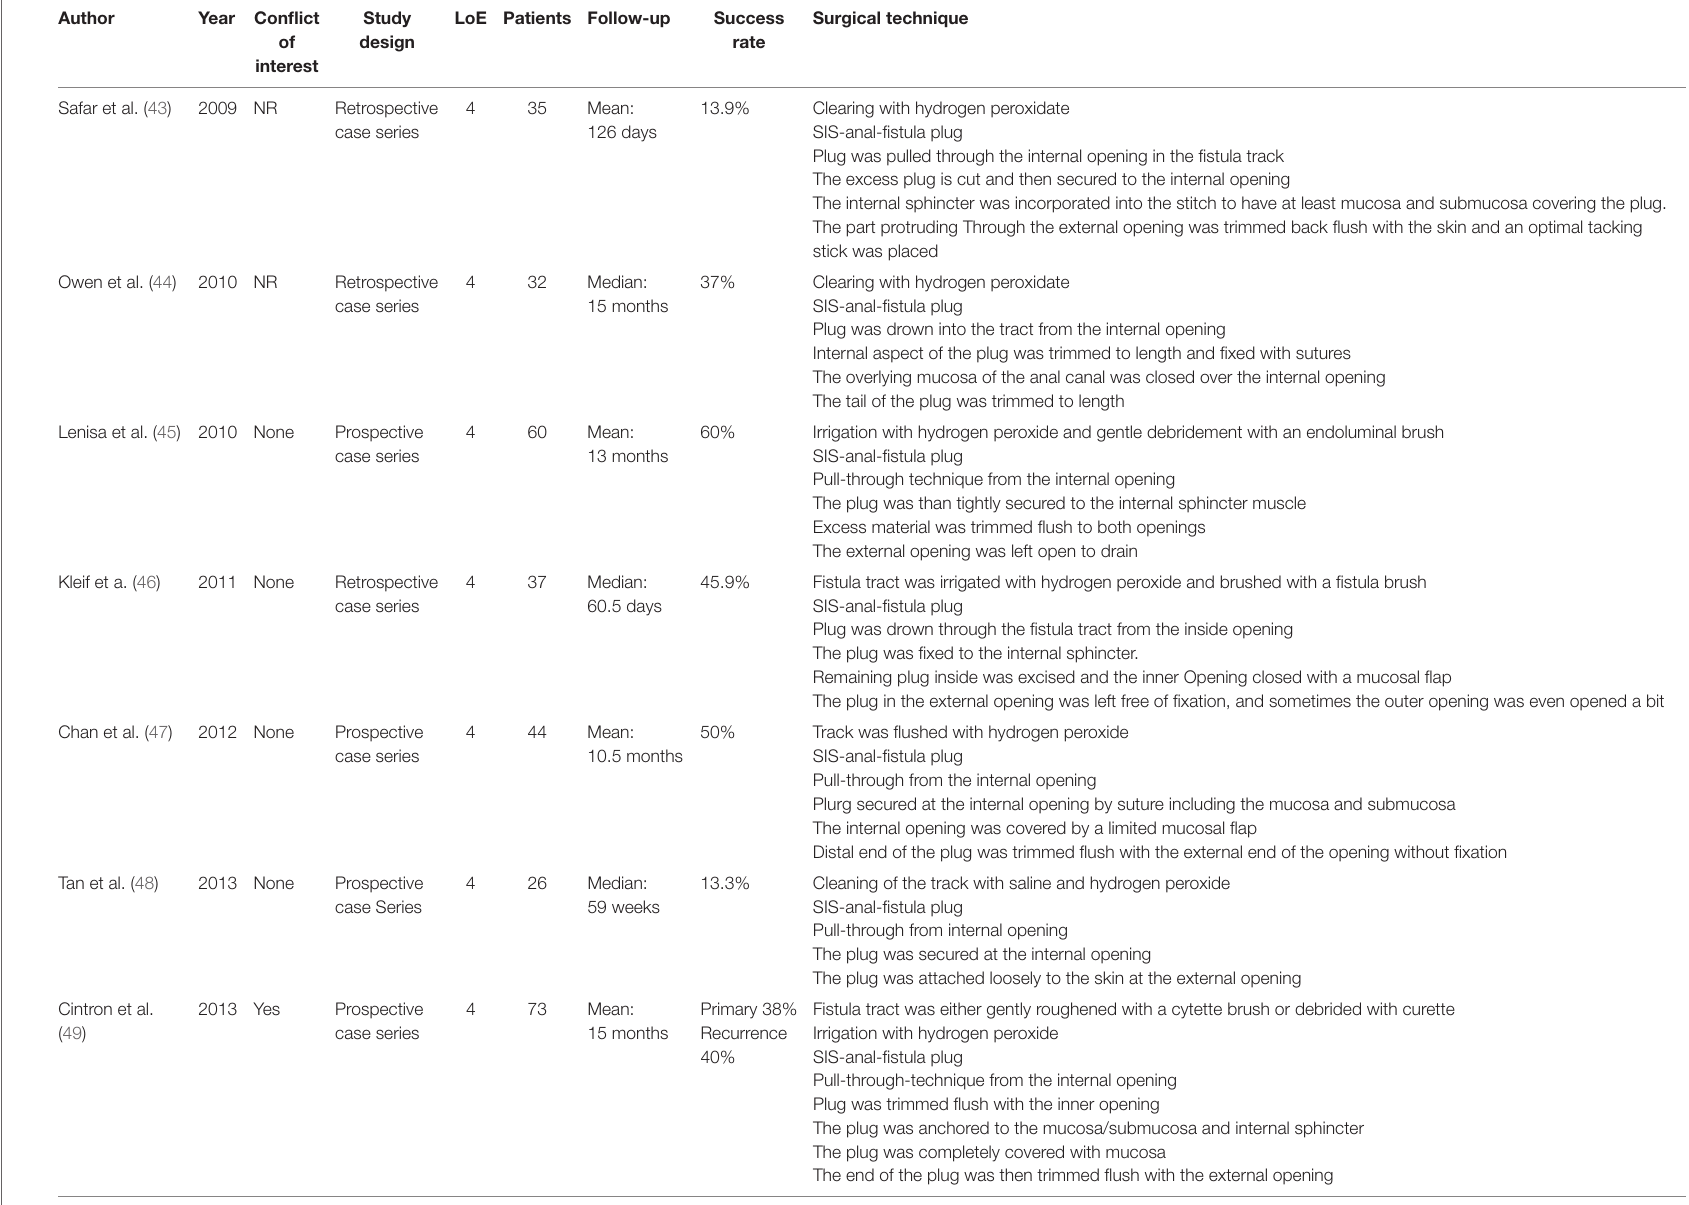
TABLe 4 | Case series of SiS-anal-fistula plug treatment not included in the systematic reviews and